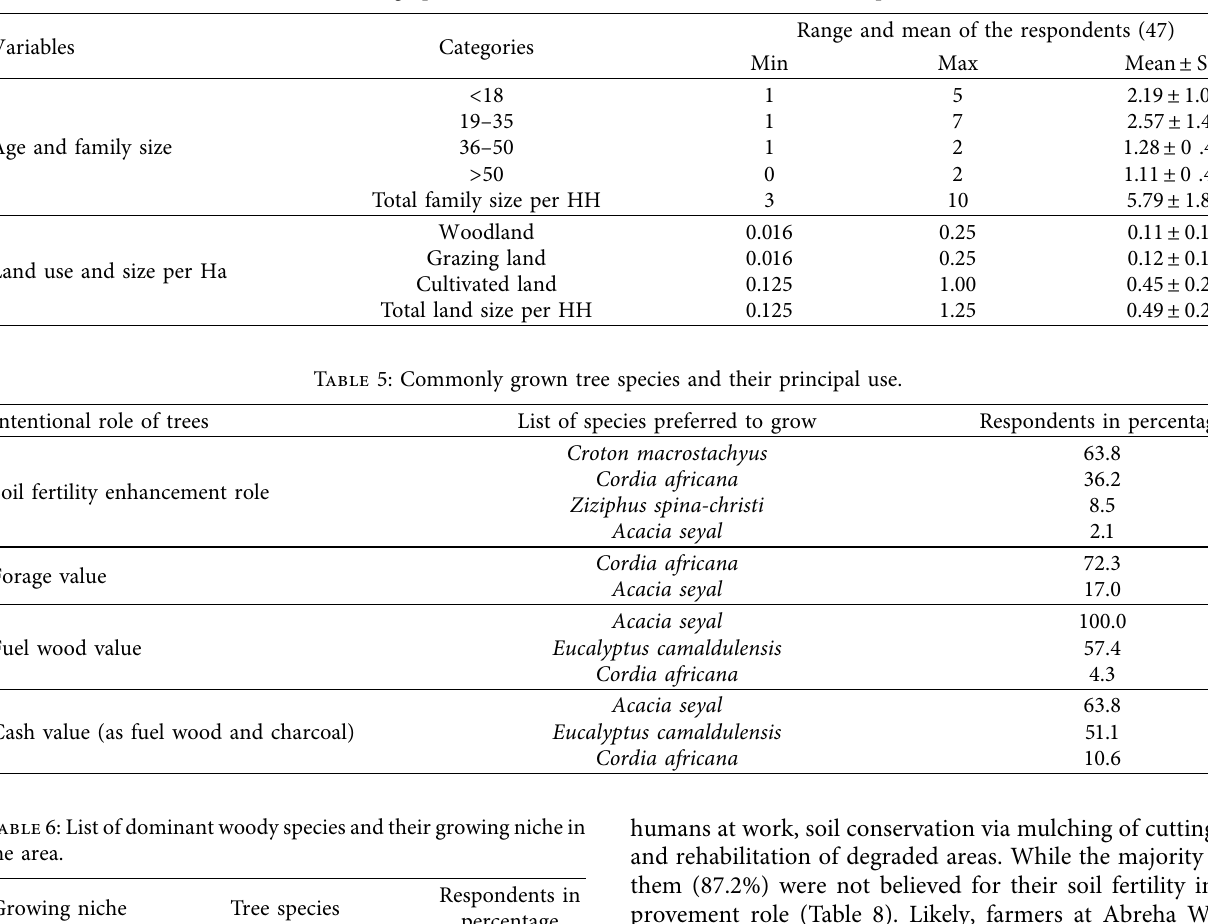
Table 4: Demographic and socioeconomic characteristics of the respondents.